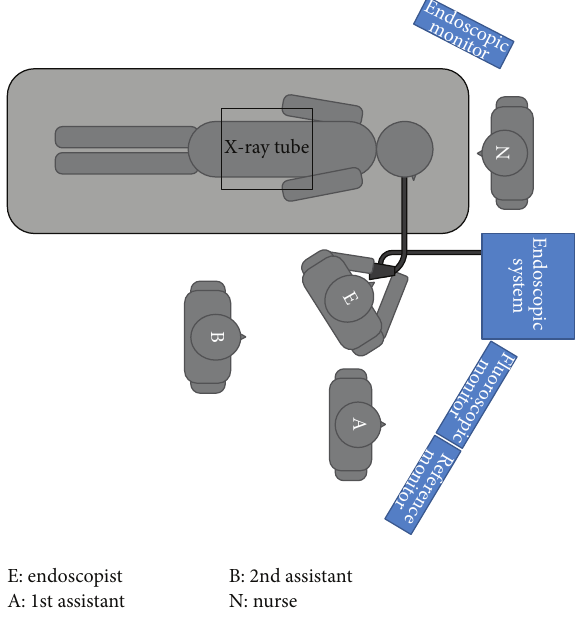
Figure2:PositionsofstaffmembersrelativetothepatientandX-ray tube during the ERCP procedure. E: Endoscopist, A: 1st assistant, B: 2nd assistant, N: nurse, and ERCP: endoscopic retrograde